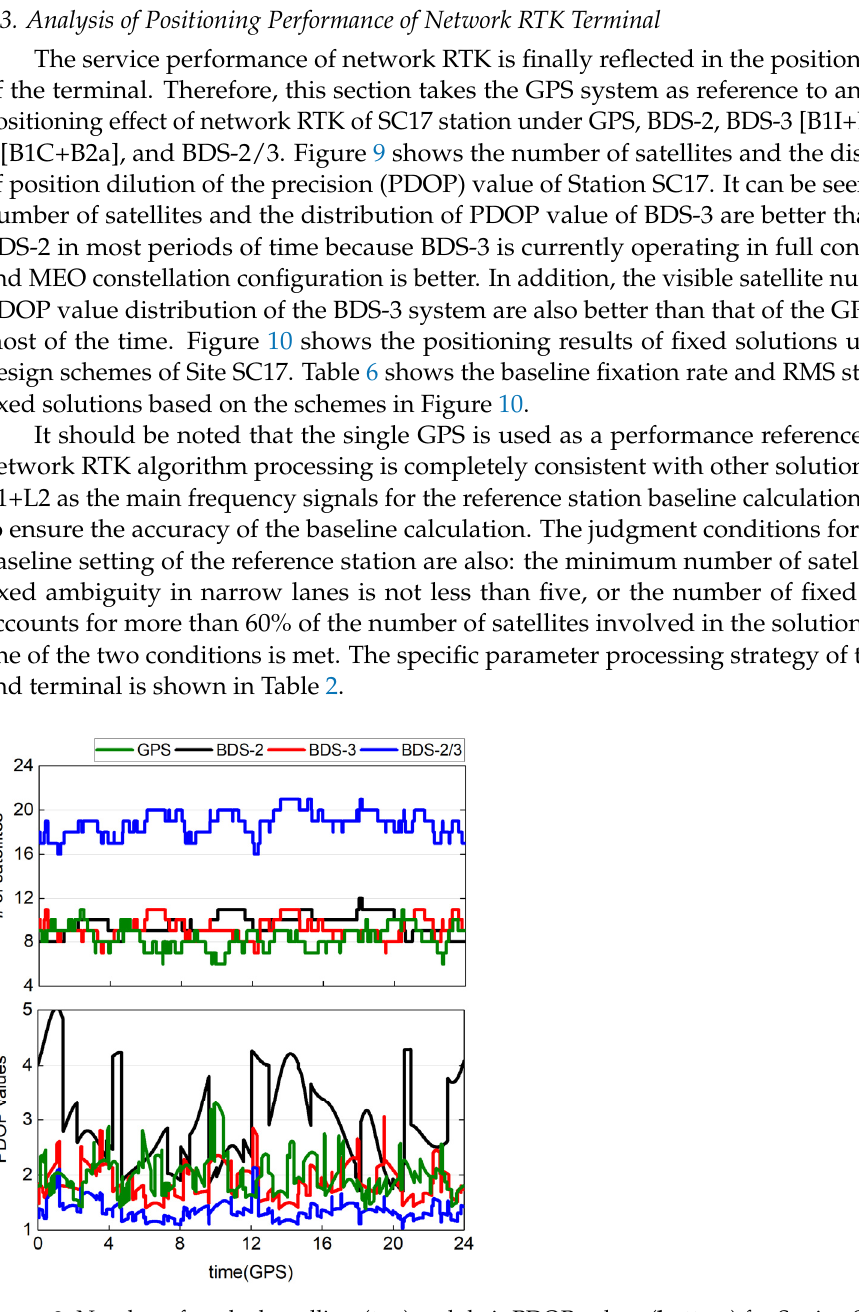
Figure 9. Number of tracked satellites ( top ) and their PDOP values ( bottom ) for Station SC17.